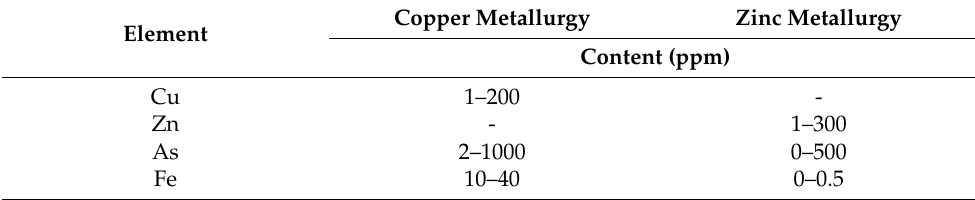
Table 1. Content of copper, zinc, iron and arsenic ions in waste acidic scrubber liquids. Copper Element